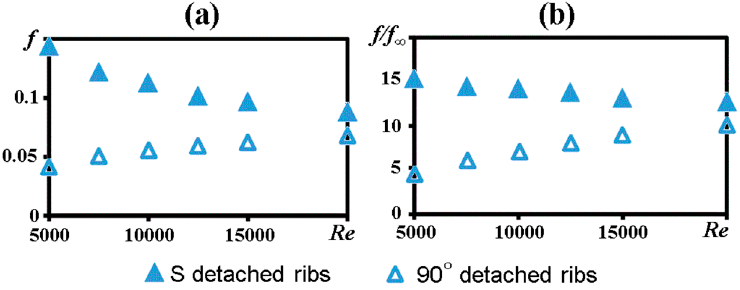
Figure 5. Variations of ( a ) f ( b ) f / f ∞ against the Reynolds number for the twin-pass parallelogram channels with detached S-ribs and 90° ribs [18].